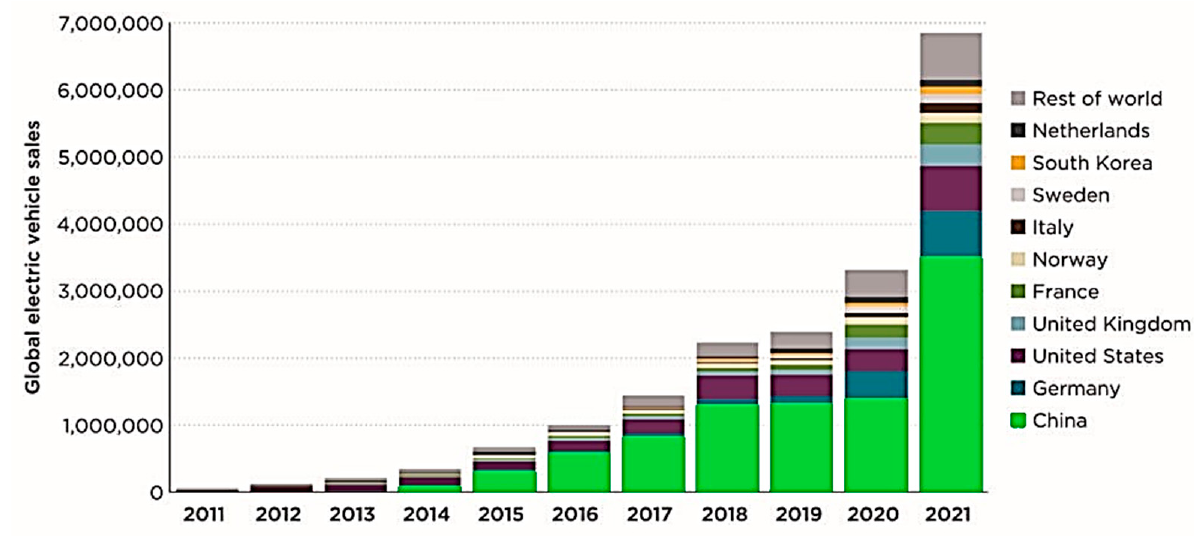
Figure 1. Annual EV sales [12].